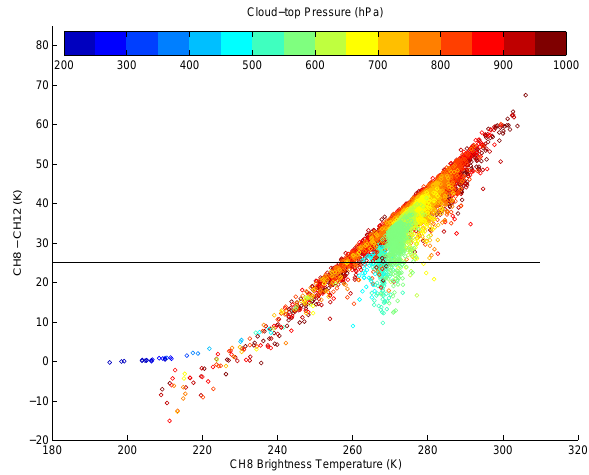
Fig. 1. RTTOV simulations of HIRS brightness temperature differ- ences between channels 8 and 12 and channel 8 brightness temper- atures based on global cloudy profiles. The primary threshold value for identification of upper tropospheric clouds is